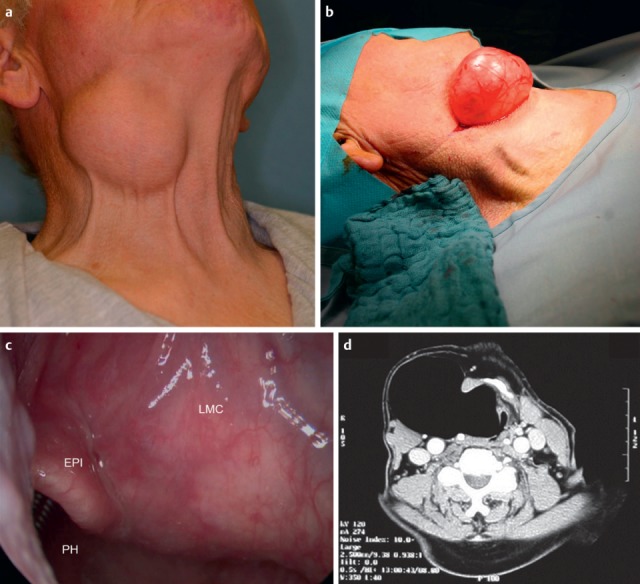
73-year-old patient with advanced right-sided internal and external laryngocele. Increasing dysphagia and muffled speech: a – clearly prominent mass at the right side of the neck; b – intraoperative situation; c – preoperative endoscopic image (LC – laryngocele, EPI – epiglottis, PH – posterior pharyngeal wall); d – horizontal CT scan of the neck with advanced right-sided laryngocele.